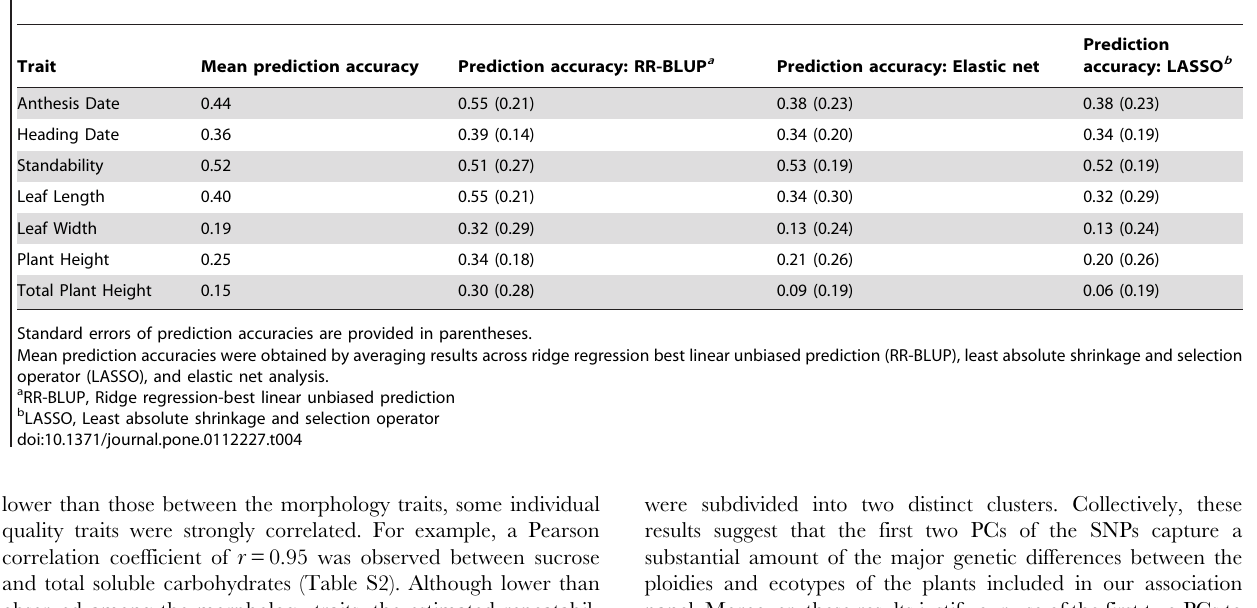
Table 4. Prediction accuracies of seven morphological traits in a switchgrass association panel.